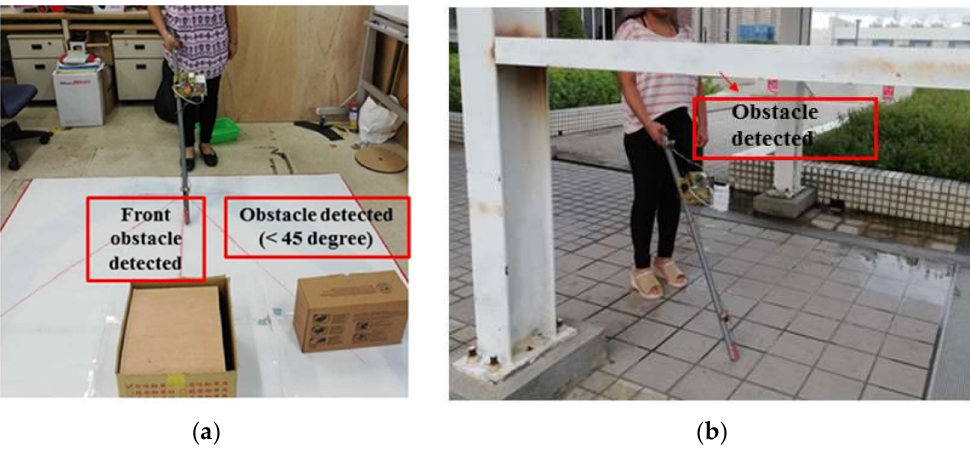
Figure 7. Experimental result of obstacle detection: ( a ) Indoor testing; ( b ) outdoor testing.